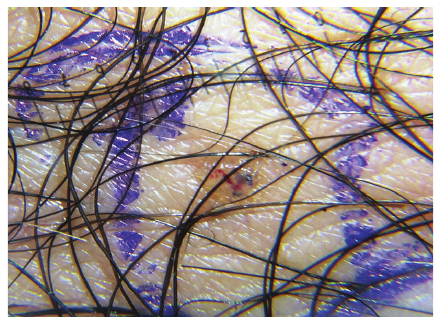
Figure 2: Photo; a louse in the pubic hair area (pretreatment).